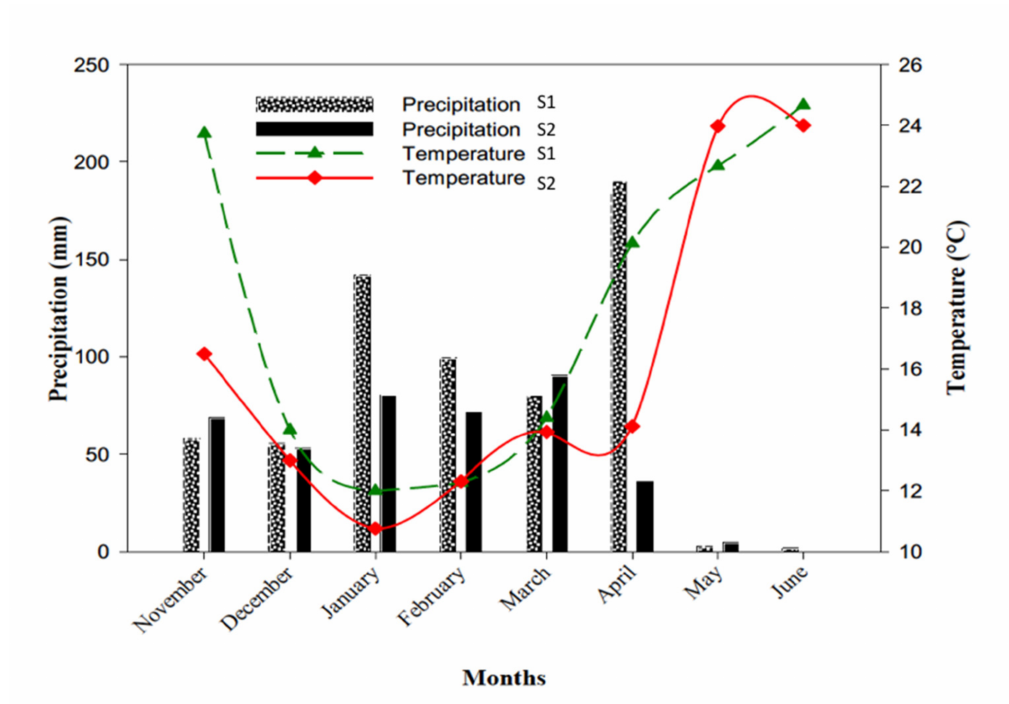
Figure 1. Meteorological data (temperature and rainfall) in S1 (2010) and S2 (2011) experimental years. The following NUE components were calculated: (i) crop N supply (CNS; kg N ha − 1 ), represented by the sum of soil nitrogen at sowing, mineralized N and N fertilizers